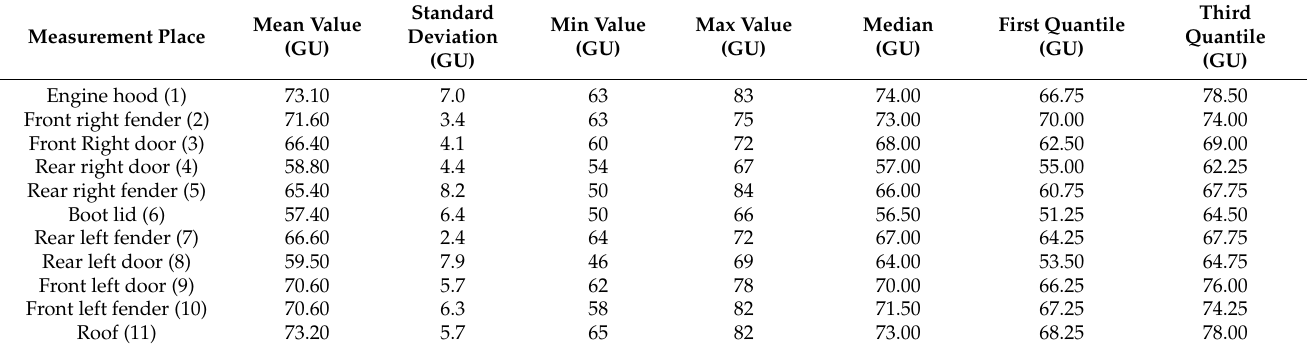
Table 3. The results of the measurements of the coating gloss (20 ◦ ) of the segment B